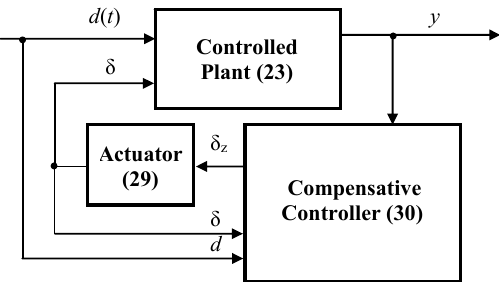
Figure 1. General scheme of the closed-loop system.